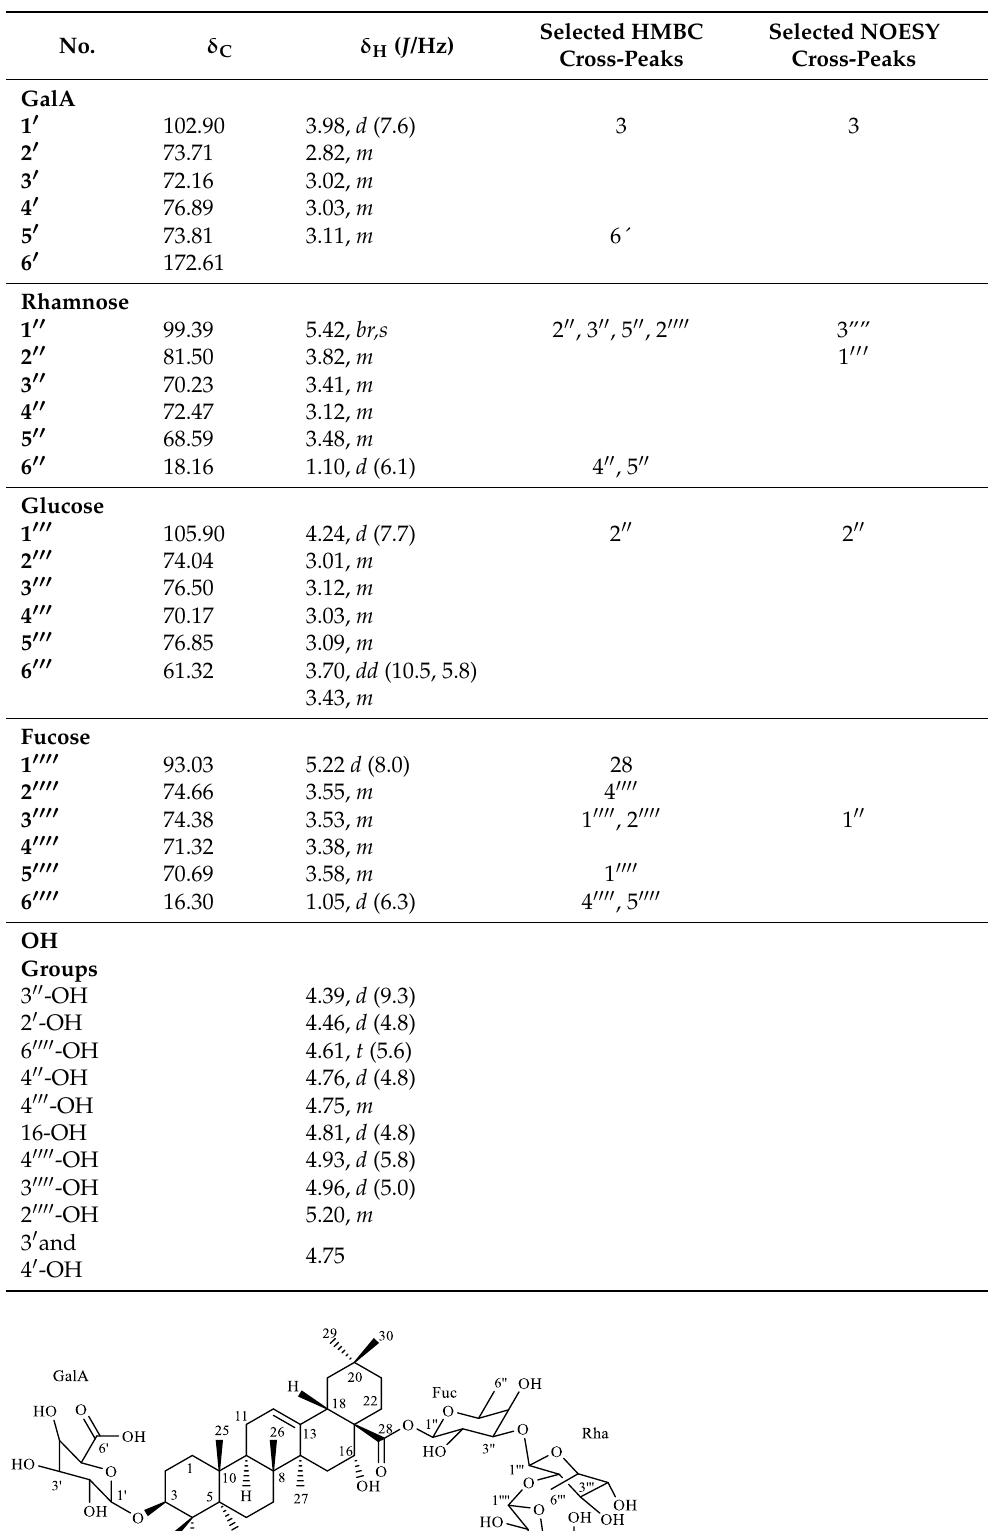
Table 2. 1 H and 13 C NMR chemical shifts with selected HMBC and NOESY cross-peaks of the sugar moieties of compound 1 (DMSO-d 6 , δ /ppm, J /Hz, and 400 MHz).